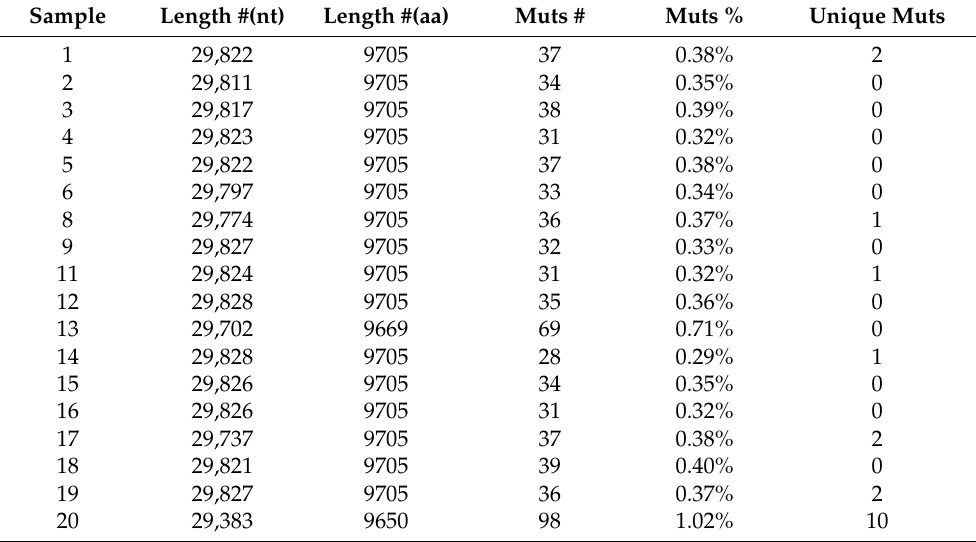
Table 2. Genome length and mutation’s pattern in SARS-CoV-2 sample.